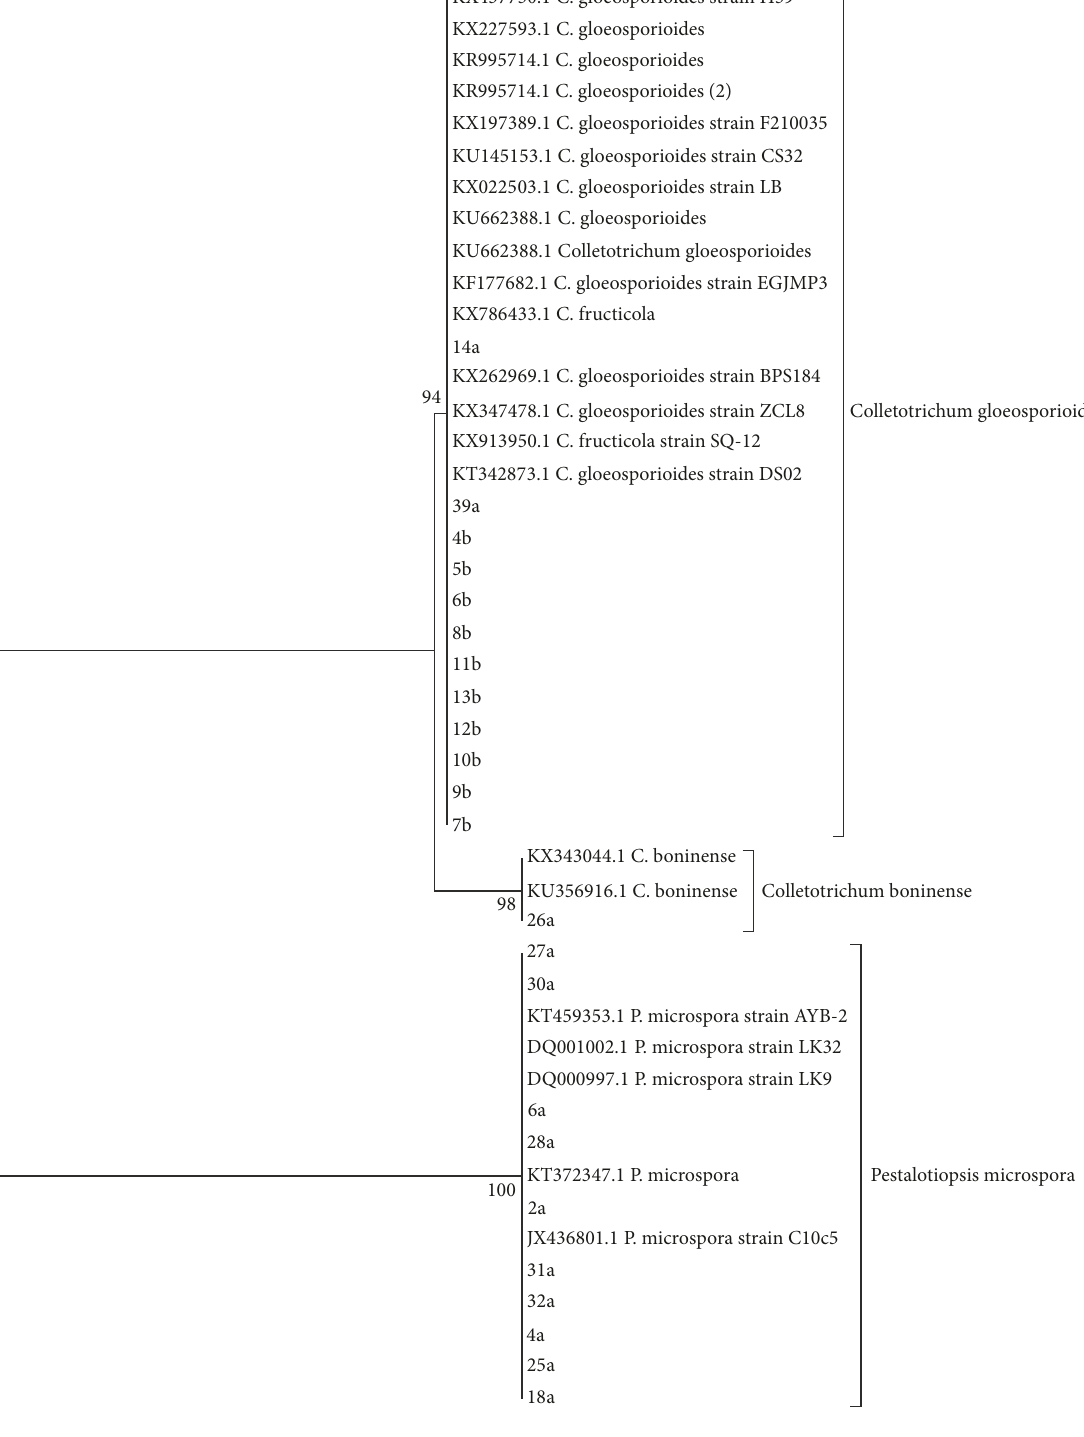
Figure 3: Maximum likelihood tree showing the relationship of Colletotrichum gloeosporioides complex and Pestalotiopsis microspora isolates based on ITS